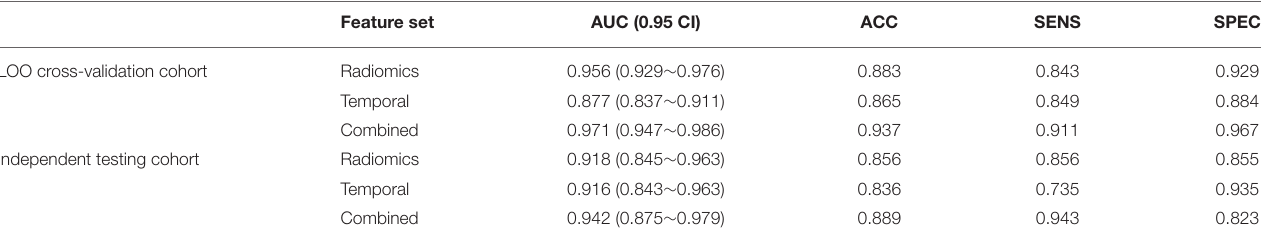
TABLE 4 | Performance comparison of the model trained by different feature